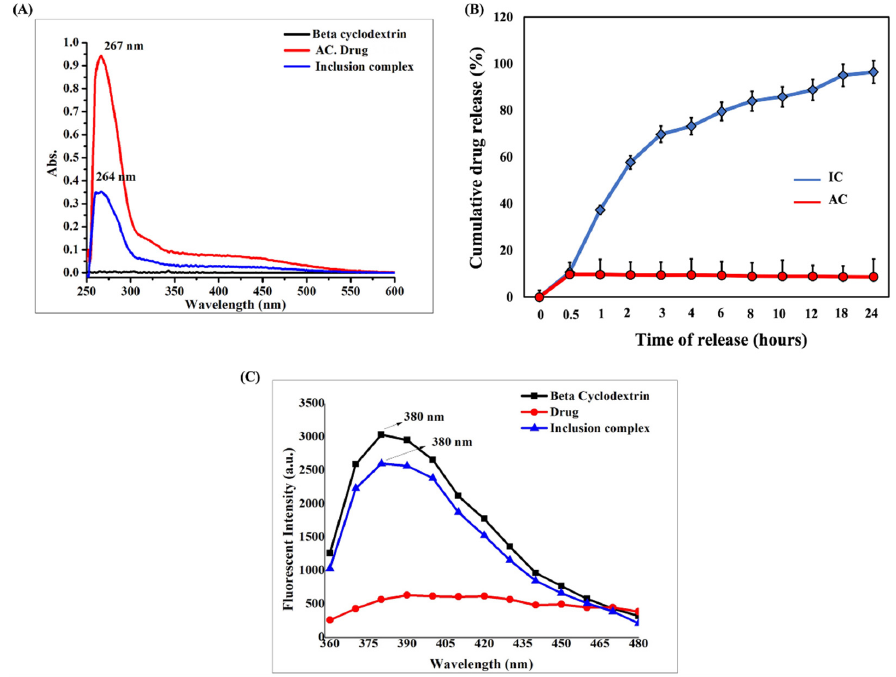
Figure 3. ( A ) UV-visible absorption spectra of BCD, AC, and IC. ( B ) In vitro dissolution profile of AC and IC in PBS (pH 7.4) ( C ) Fluorescent spectra of BCD, AC, and IC.